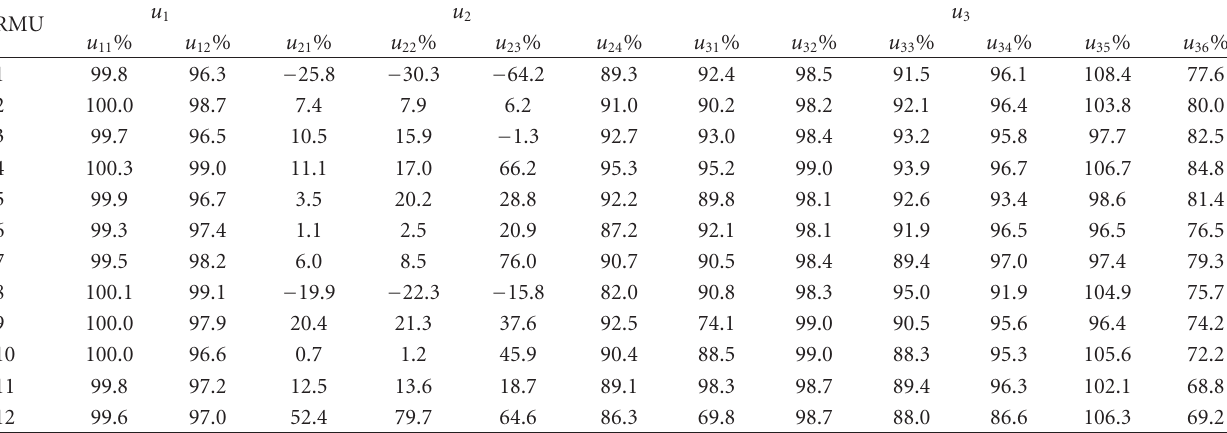
Table 2: The statistical data of 12 RMUs in